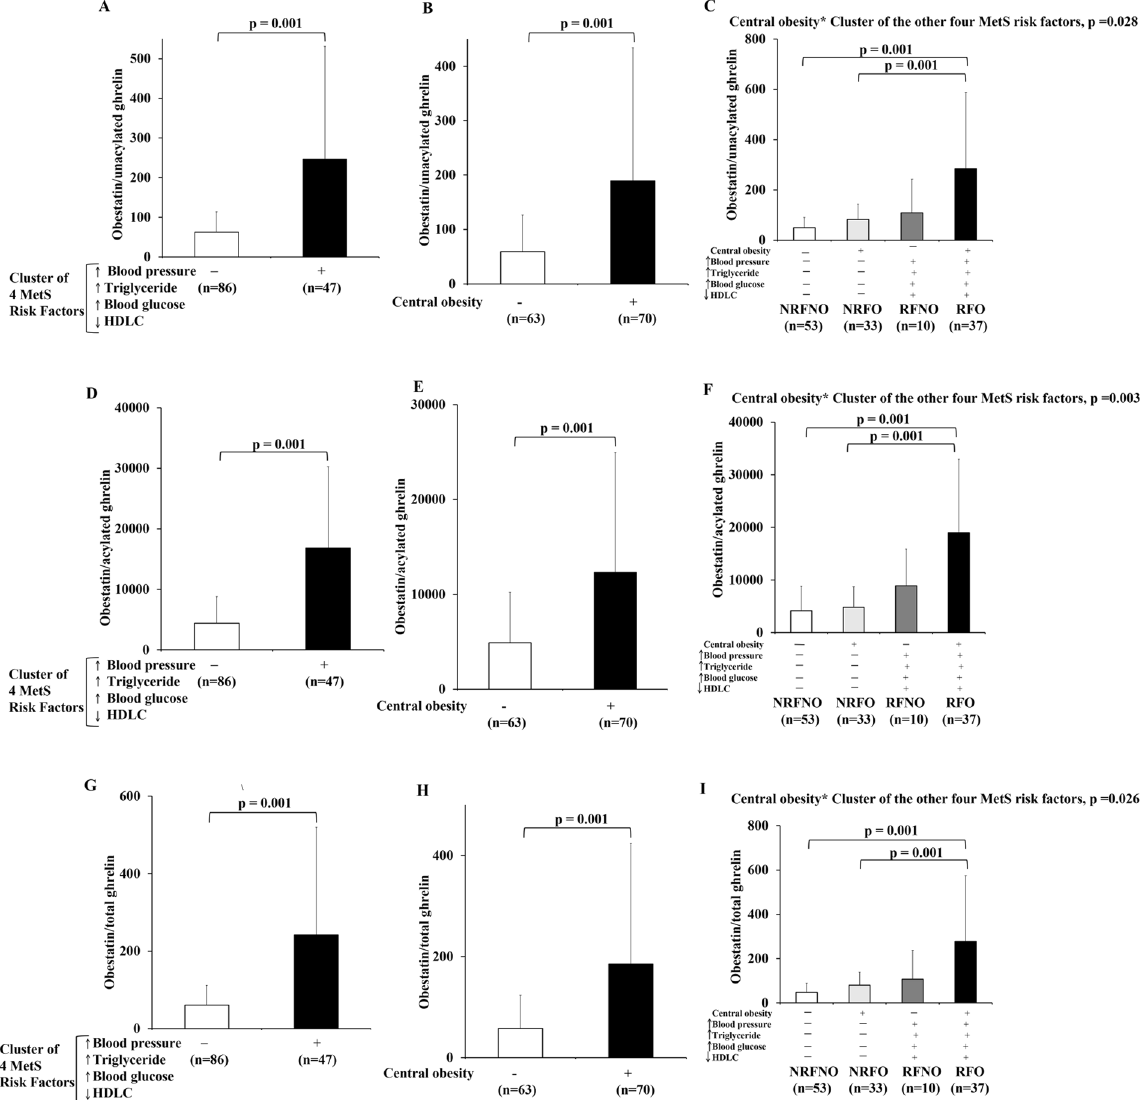
Figure 2. Ratios of ghrelin gene products in response to CO or the cluster of the other four MetS risk factors alone as well as CO in conjunction with the cluster of the other four MetS risk factors. The ratios of obestatin/unacylated ghrelin, obestatin/acylated ghrelin and obestatin/total ghrelin of subjects with/without the cluster of four MetS risk factors regardless of the status of CO (RFNO and RFO vs NRFNO and NRFO) ( A,D,G ). The ratios of obestatin/unacylated ghrelin, obestatin/acylated ghrelin and obestatin/total ghrelin of subjects with/without CO regardless of the status of the cluster of four MetS risk factors (NRFNO and RFNO vs NRFO and RFO) ( B,E,H ). Comparison of ratios of obestatin/unacylated ghrelin, obestatin/acylated ghrelin and obestatin/total ghrelin among subjects with no MetS risk factors (NRFNO), central obese only (NRFO), the cluster of the other MetS risk factors other than central obese (RFNO), and all MetS risk factors (RFO) ( C,F,I